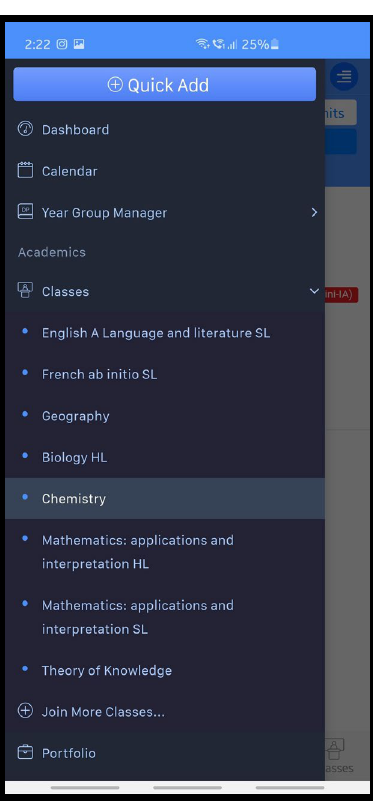
Figure 4d. Student View of Assigned Class